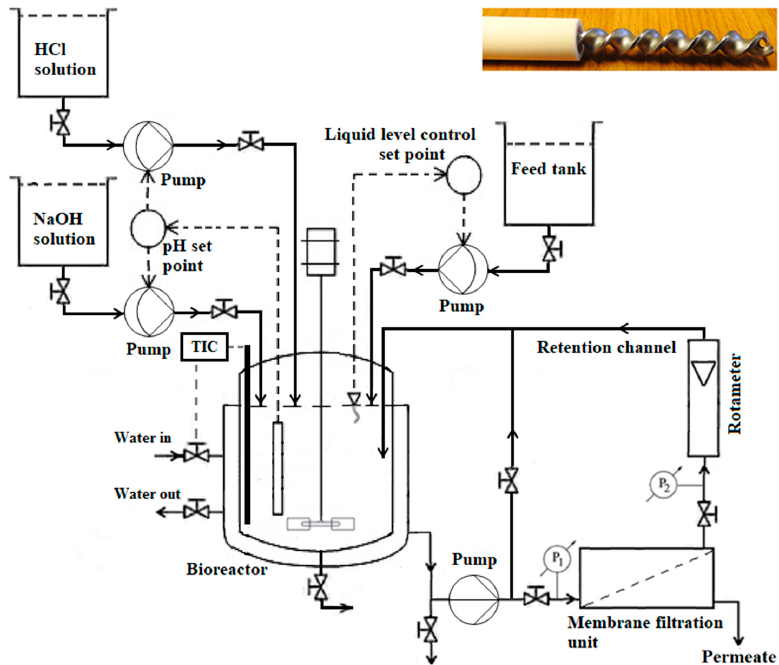
Figure 1. Schematic diagram of membrane bioreactor (inset: Ceramic tubular membrane with twisted tape static turbulence